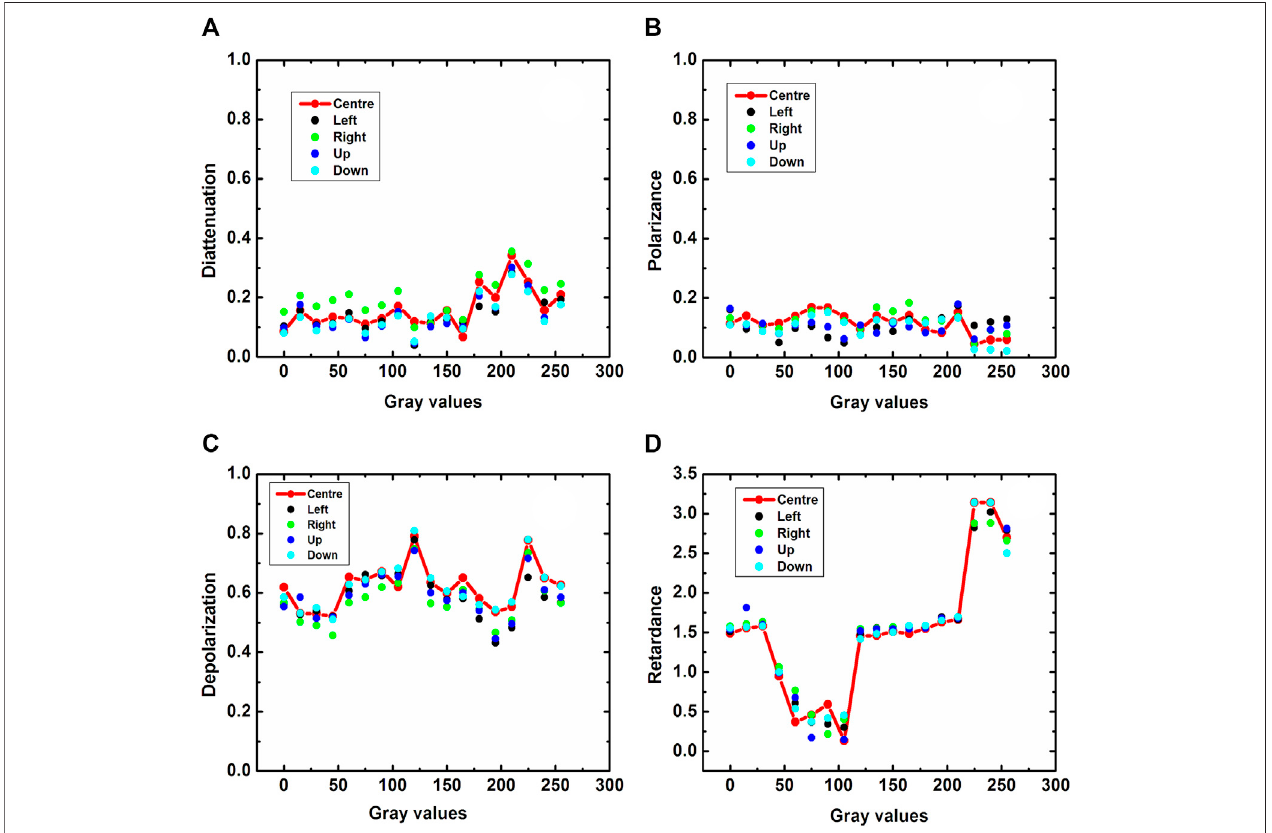
FIGURE 5 | Polarization characteristics [ (A) diattenuation, (B) polarizance, (C) depolarization, and (D) retardance] of SLM as function of gray values of SLM at differentspatiallocations[centralpart(reddots),leftedge(black dots),rightedge(green dots),up(bluedots),anddown(sky-bluedots)]ofSLMdisplay. Redcoloredline represents the polarization characteristics variation in central part of SLM